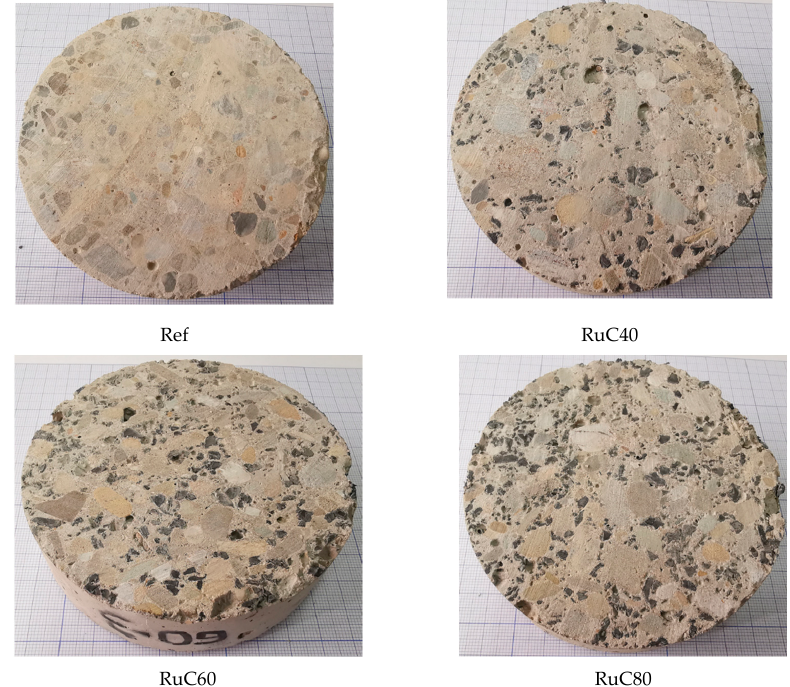
Figure 2. Distribution of rubber aggregates in concrete specimens at the age of 28 days. The static longitudinal modulus of elasticity was assessed in accordance with speci- fications of SR EN 12390:13 [14]. Cyclic loading was applied within limits mentioned in the code, and three individual values were obtained for each specimen. One cylinder was loaded in compression until failure in order to set the correct upper and lower limits of the loading cycles, as shown in Figure 3a. Therefore, the static longitudinal modulus of elasticity was assessed for 19 specimens only, with 3 distinct measurements for each spec- imen. The experimental setup is shown in Figure 3b. A hinge was used between the load- ing platens of equipment and the concrete cylinder in order to ensure an even distribution of the compressive load. ( a ) ( b ) Figure 3. Assessment of the static modulus of elasticity. ( a ) Standard loading scenario; ( b ) Experimental setup. The compressive and splitting tensile strengths were determined in accordance with SR EN 12390:3 [15] and SR EN 12390:6 [16], respectively. The considered loading rate for determining the compressive strength was 0.6 MPa/s (4.71 kN/s), whereas, for the tensile splitting strength, a loading rate of 0.05 MPa/s (0.4 kN/s) was adopted. The dynamic longitudinal modulus of elasticity, E d , was assessed following the guidelines of ASTM C215:14 [17] and was based on the first resonant frequency (FRF) obtained from the Impact Echo Method. The experimental setup is shown in Figure 4. An accelerometer was placed at one end of the concrete cylinder along the longitudinal axis of the specimen to record the response of the sample when subjected to a small impact